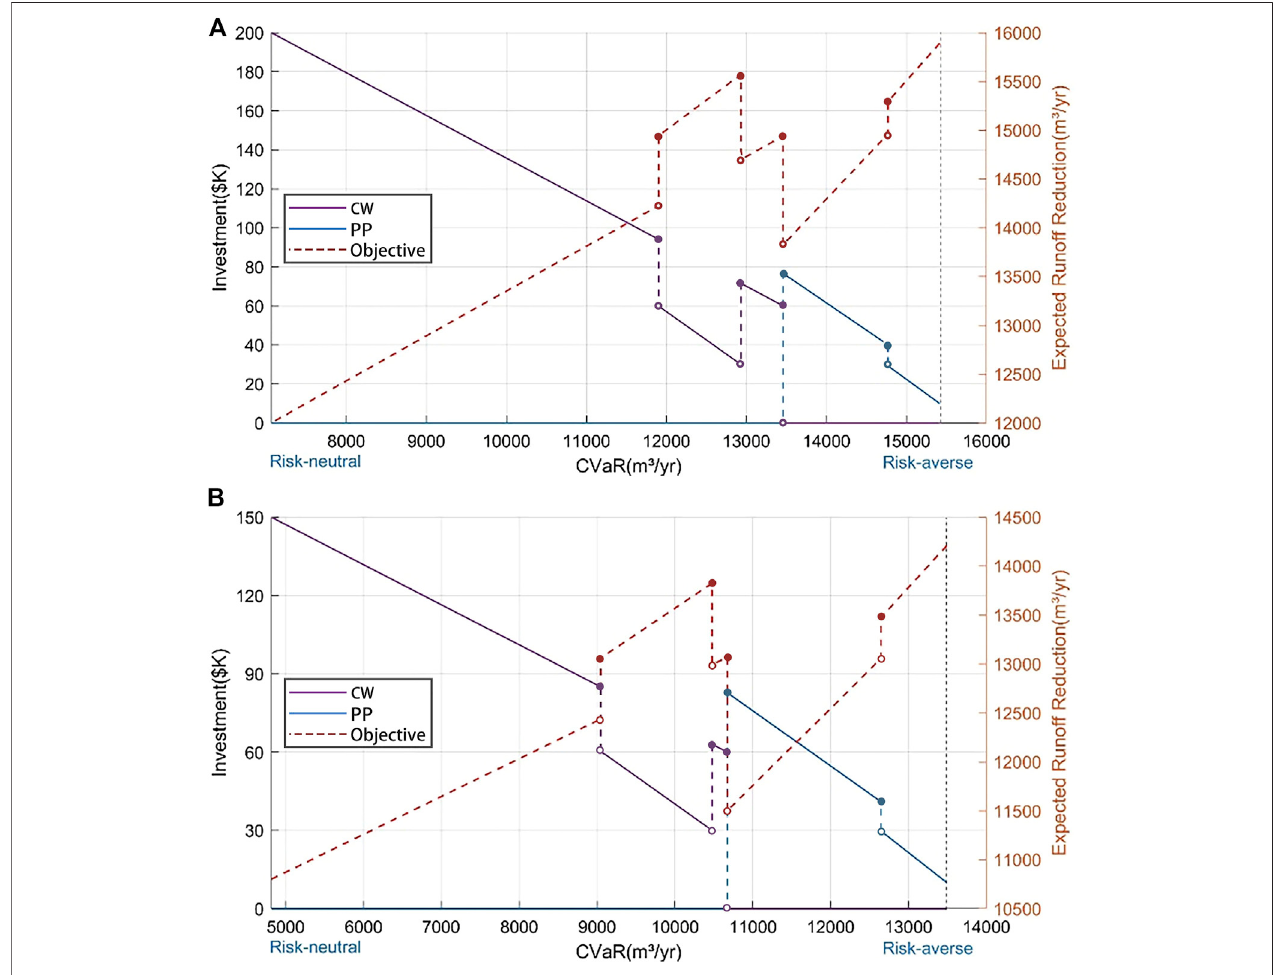
FIGURE 8 | Investment strategies at Stage I (left axis) , and the objective function values (right axis) from the MVL model for CVaR0.05 in (A) S01 and (B) S02.